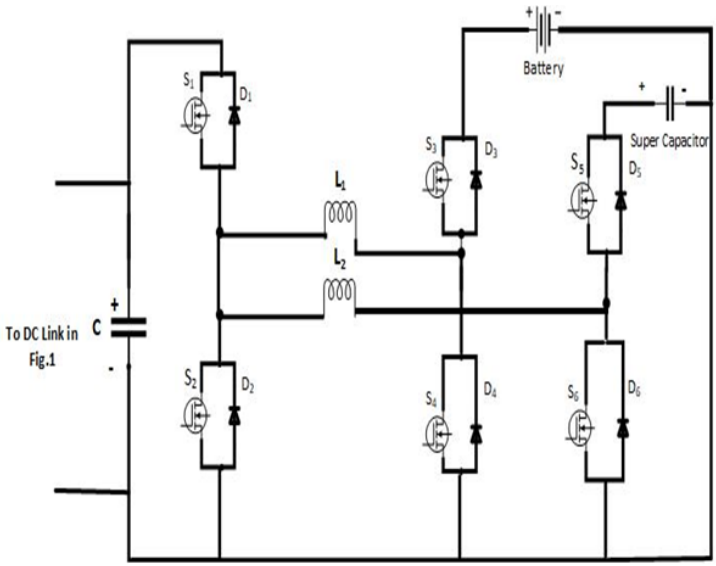
Figure 4. Schematic of the proposed converter.